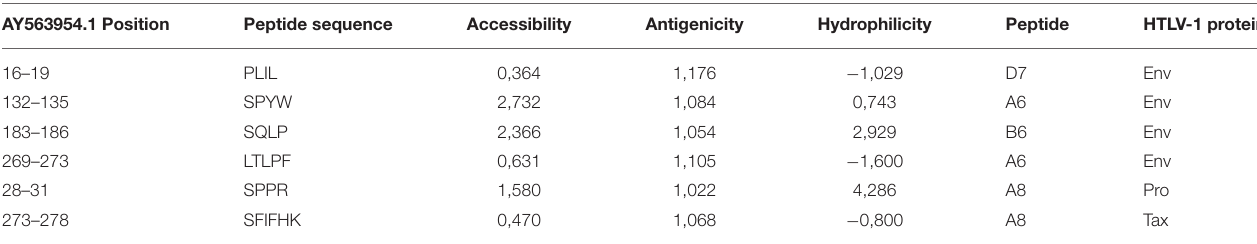
TABLE 3 | Accessibility, antigenicity and hydrophilicity values using the Emini, Kolaskar and Parker scales for the clones located in the envelope protein (gp46), protease and Tax. AY563954.1